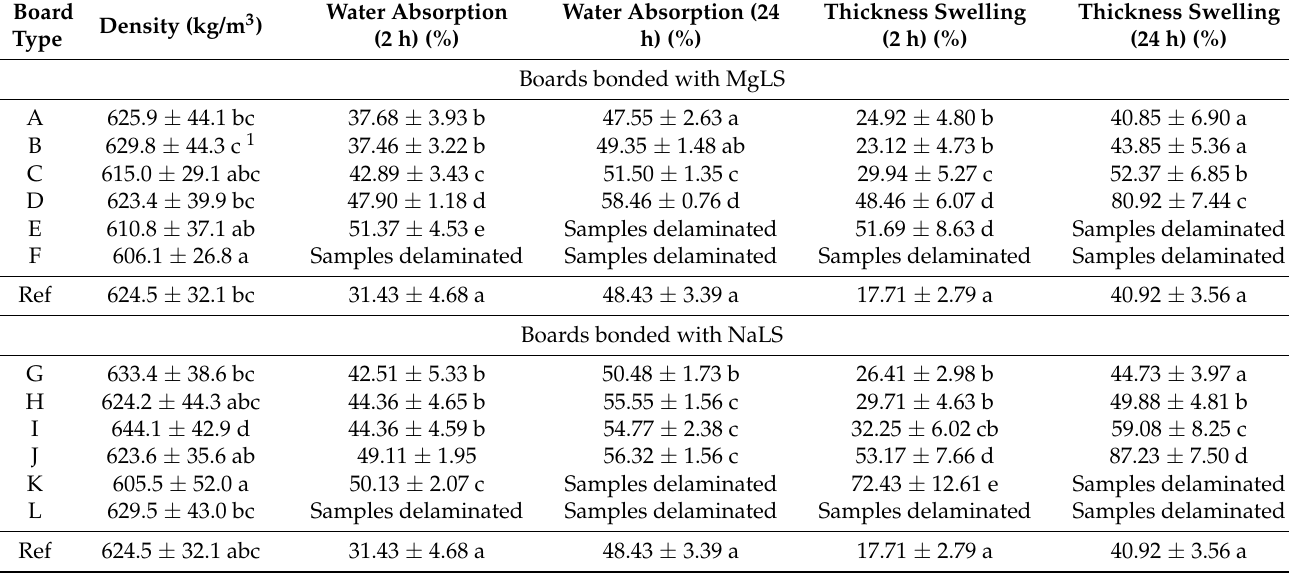
Table 6. Physical properties of particleboards produced in this